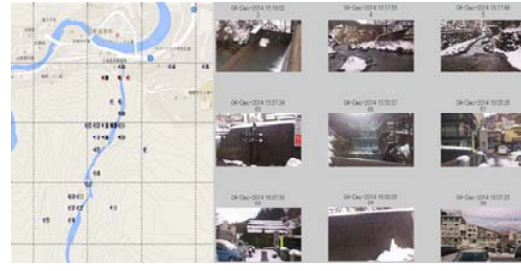
Figure 16. Geotagged images